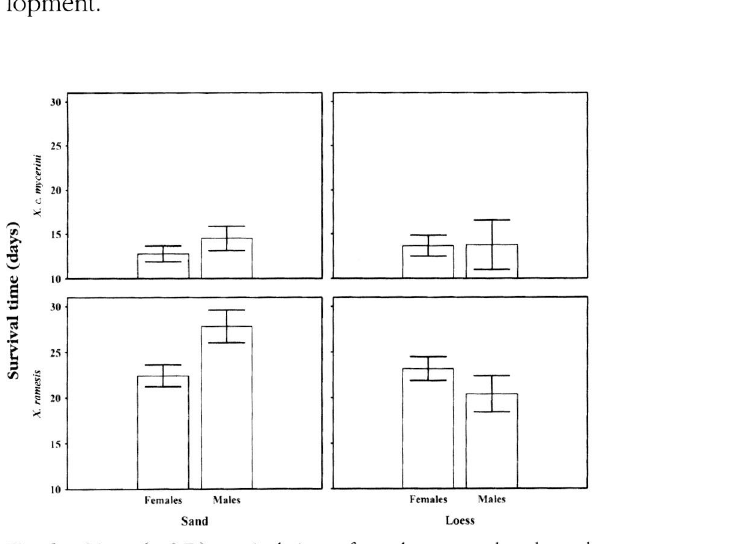
Fig. 5 - Mean (± S.E.) survival time of newly emerged male and female X. c. mycerini and X. ramesis in different